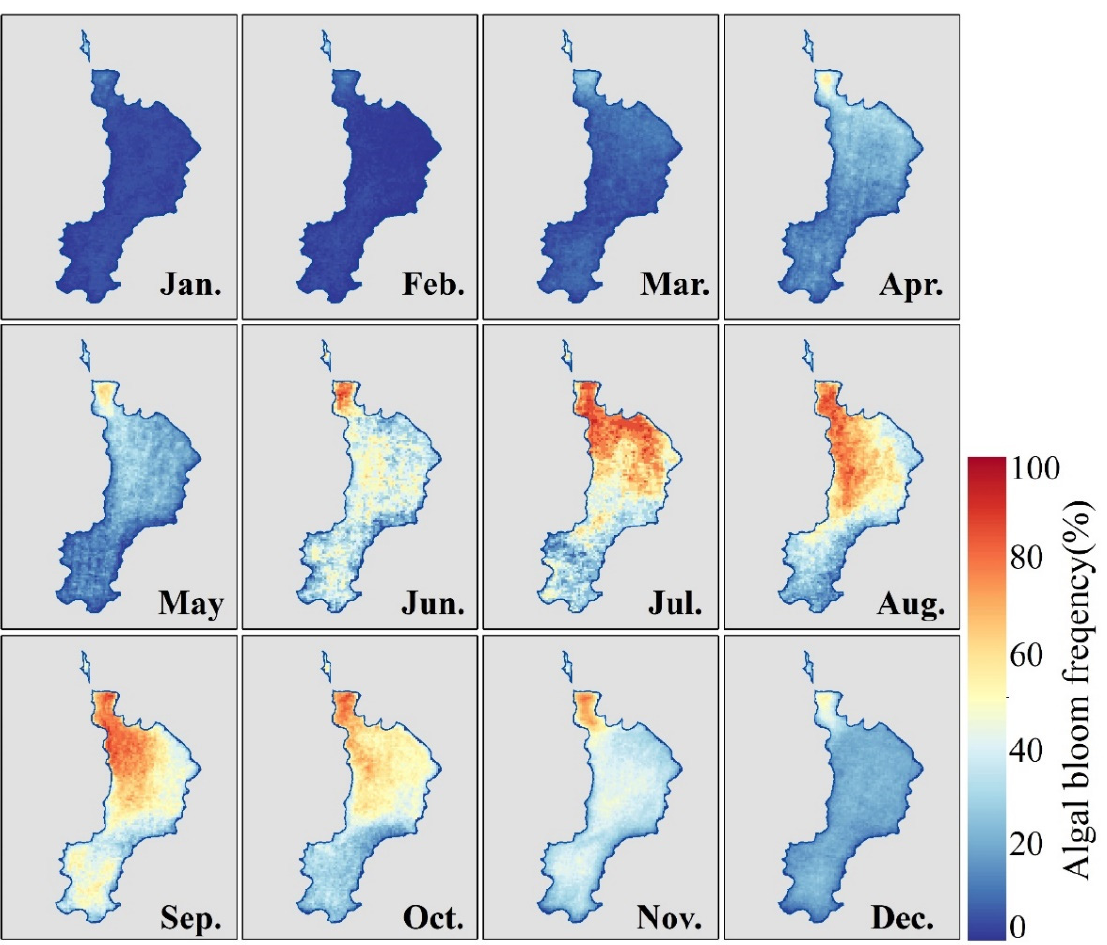
Figure 7. Monthly average bloom frequency distributions derived from MODIS/Terra imagery (2000 − 2021) for Lake Dianchi in China.